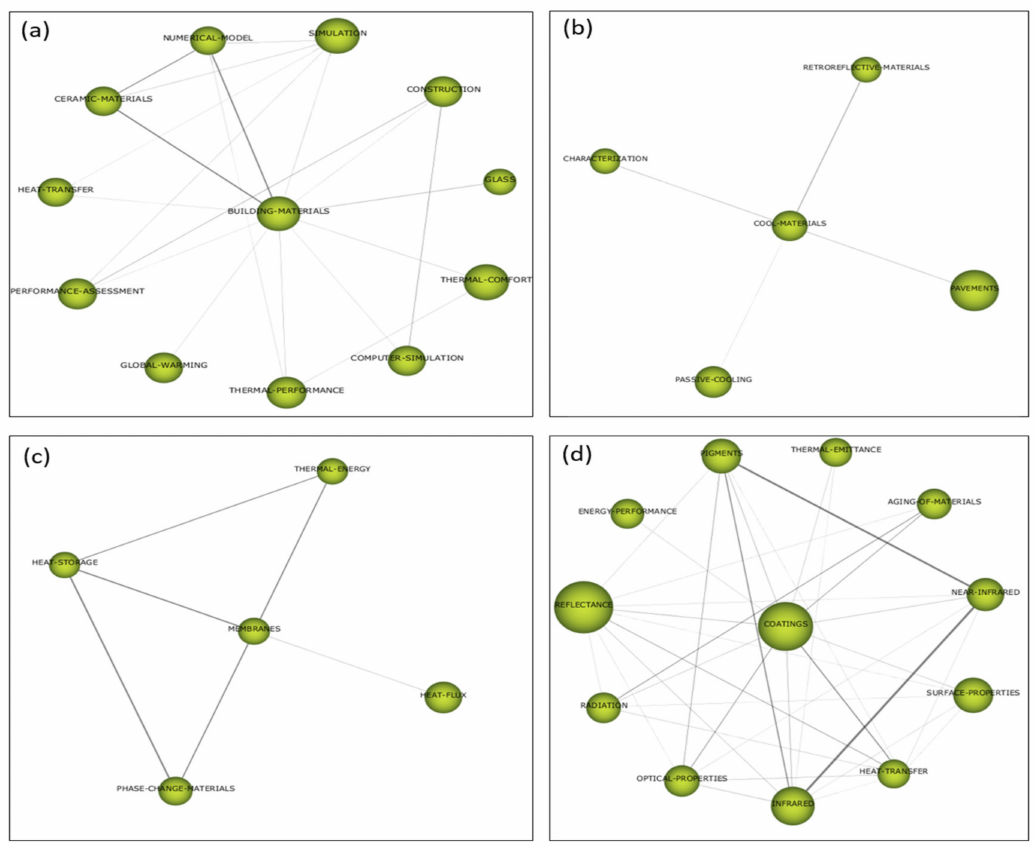
Figure 8. Cluster networks of: ( a ) building-materials; ( b ) cool-materials; ( c ) membranes; and ( d )